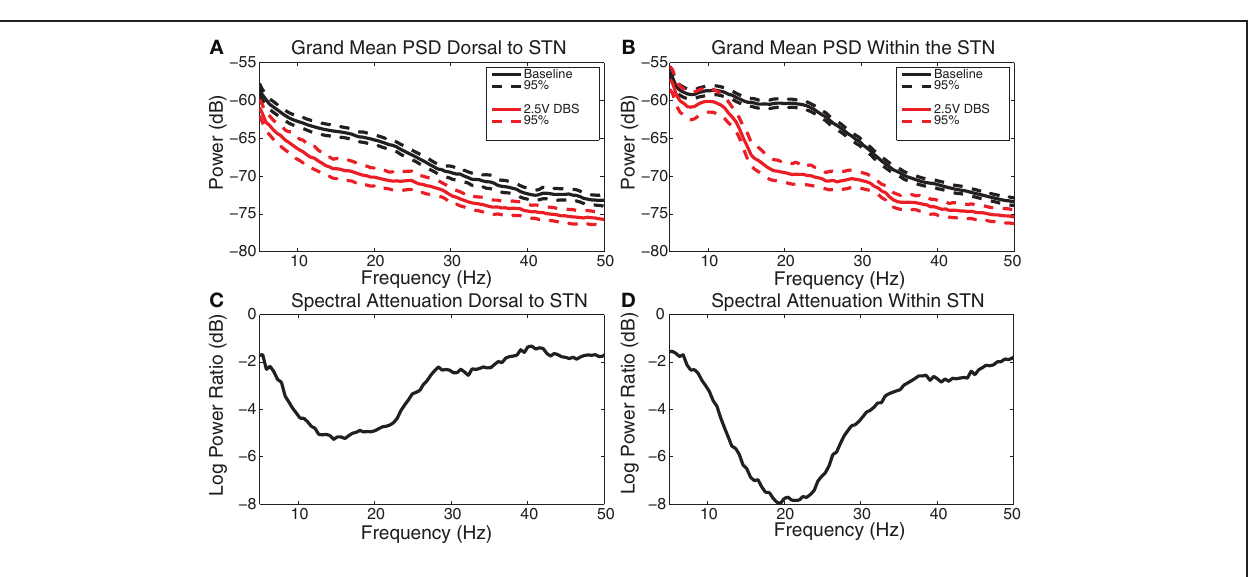
FIGURE 5 | DBS-induced spectral attenuation. (A) Group mean power spectral density before (black) and during (red) 2.5V DBS applied dorsal to the STN with 95% confidence limits. (B) Group mean power spectral density before (black) and during (red) 2.5V DBS applied within the STN with 95%